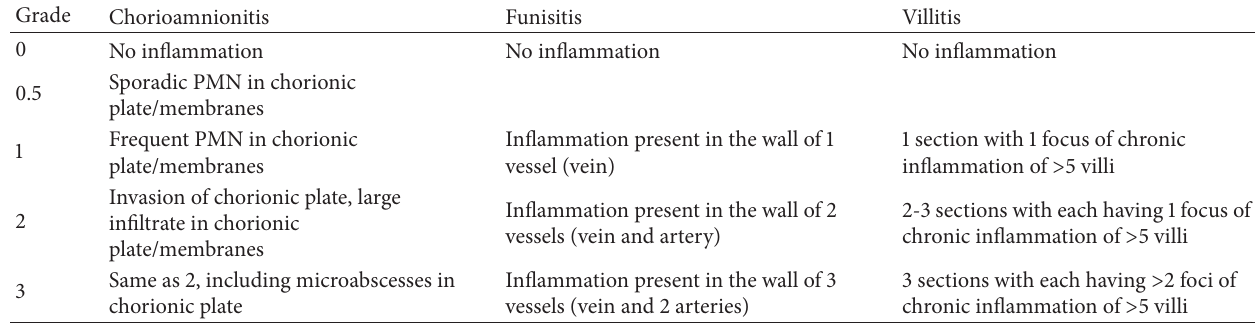
Table 1: Histological classification of chorioamnionitis, funisitis, and